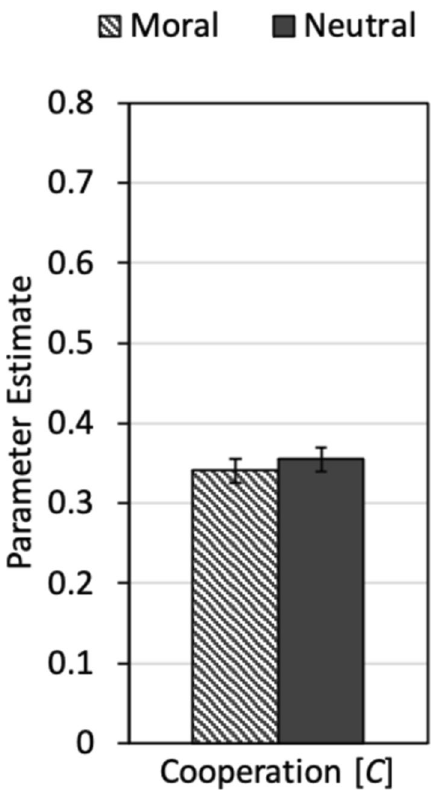
Figure 4. Parameter estimates of parameter C reflecting the probability that a participant decided to cooperate as a function of framing (moral, neutral). The error bars represent standard errors.